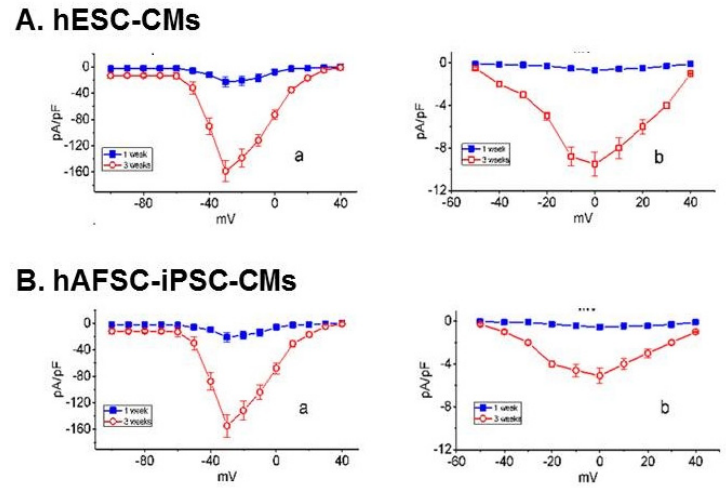
Figure 3. The averaged relationships of voltage-gated Na + current ( I Na , A a and B a) or voltage-gated L-type Ca 2+ current ( I Ca,L , A b, and B b) density versus membrane potential recorded either from hESC-CMs (panel A) or hAFSC-iPSC-CMs (panel B) at 1- and 3-week of cardiac differentiation. To measure I Na or I Ca,L , cells were bathed in Ca 2+ -free Tyrode’s solution while the recording electrode was backfilled with Cs + -containing solution. To elicit I Na , the examined cells were briefly depolarized from –80 to various potentials ranging between –100 and +40 mV in 10-mV step. For the recording of I Ca,L , the cells were voltage-clamped at –50 mV and the depolarizing command potentials ranging between –50 and +40 mV were applied. Each data point represents the mean ± SEM ( n = 8).